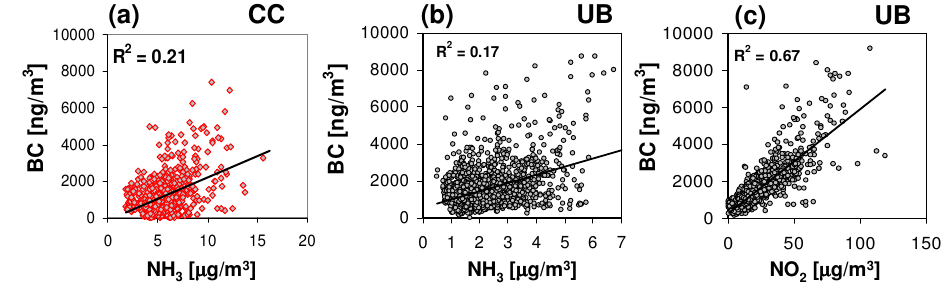
Fig. 7. Correlation between: (a) NH 3 and BC concentrations at CC, (b) NH 3 and BC concentrations at UB, and (c) BC and NO 2 concentra- tions at